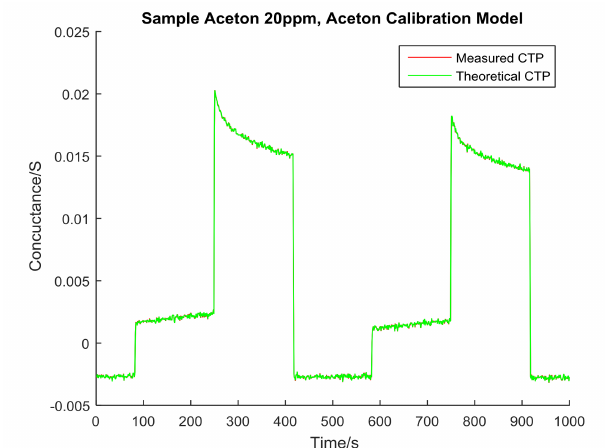
Figure 5. Comparison of measured CTP of an acetone sample and the related theoretical CTP based on the acetone calibration model.